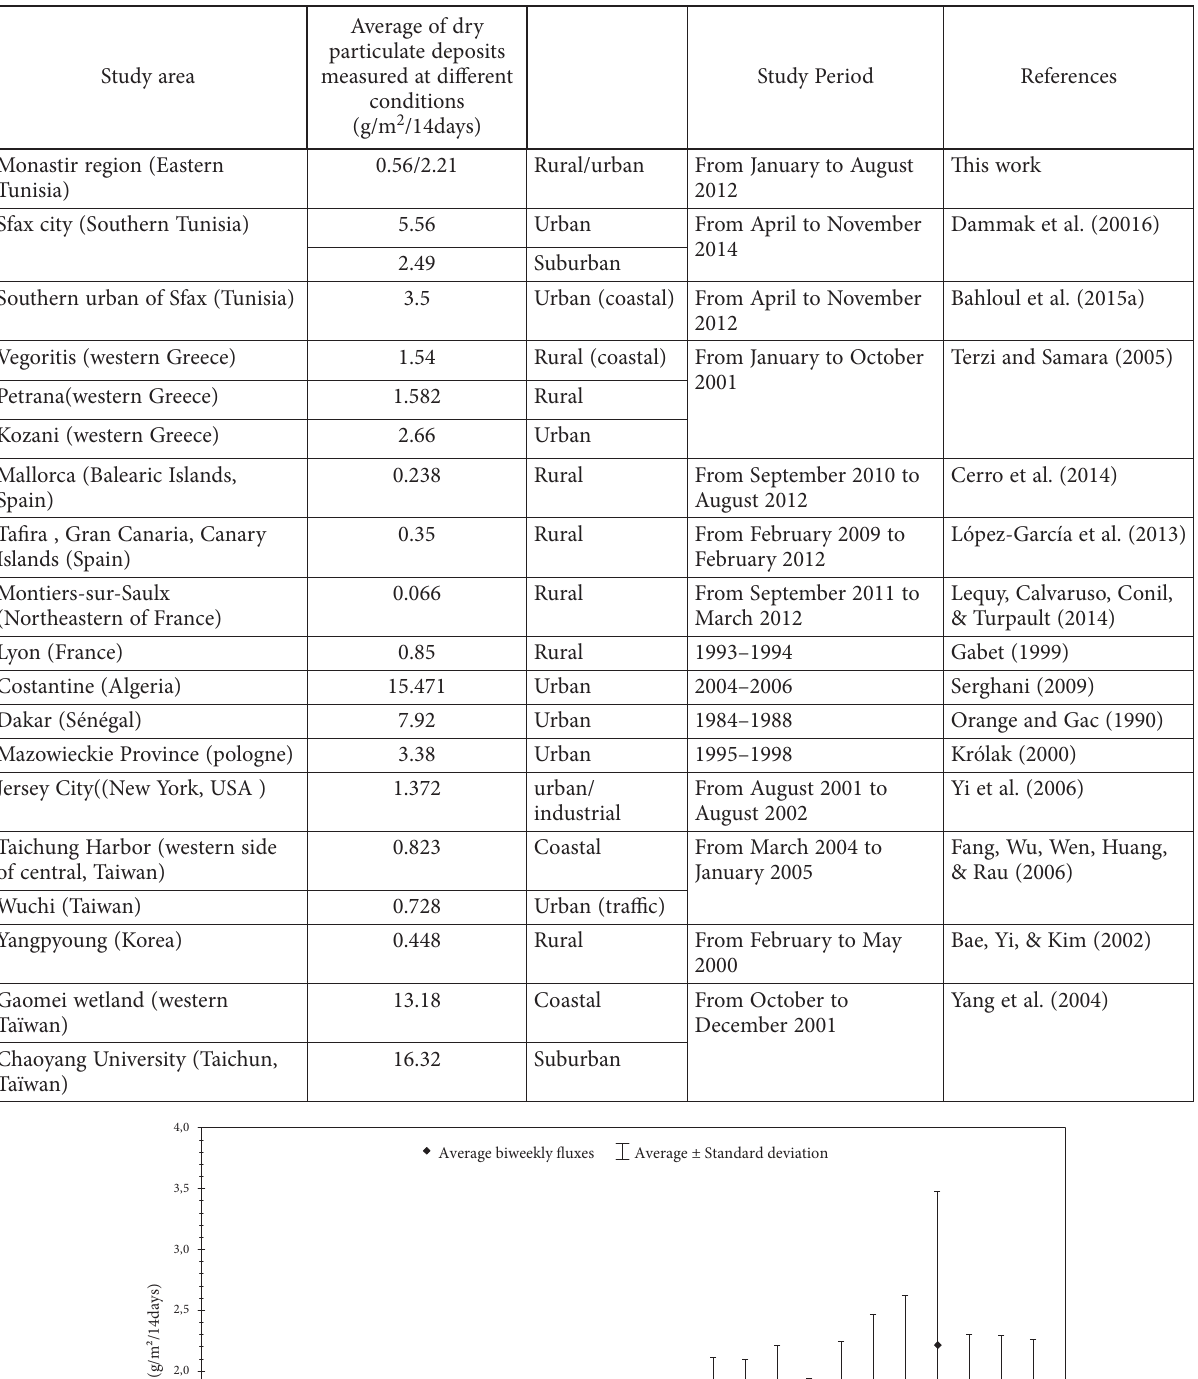
Table 2. Fluxes of particulate deposits (g/m 2 /14days) measured at different conditions from several areas over the world